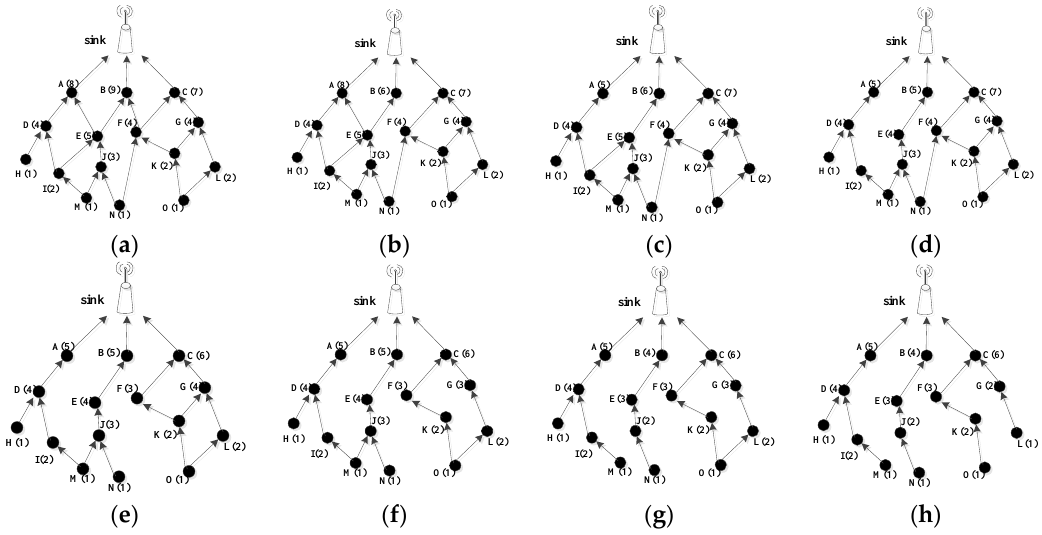
Figure 2. Example of the edge-cutting process. (Note: the value in parentheses indicates the corresponding node load, ( a ) is the minimum routing graph, ( h ) is the minimum routing tree, ( a – h ) show the edge-cutting process from the minimum routing graph to the minimum routing tree).